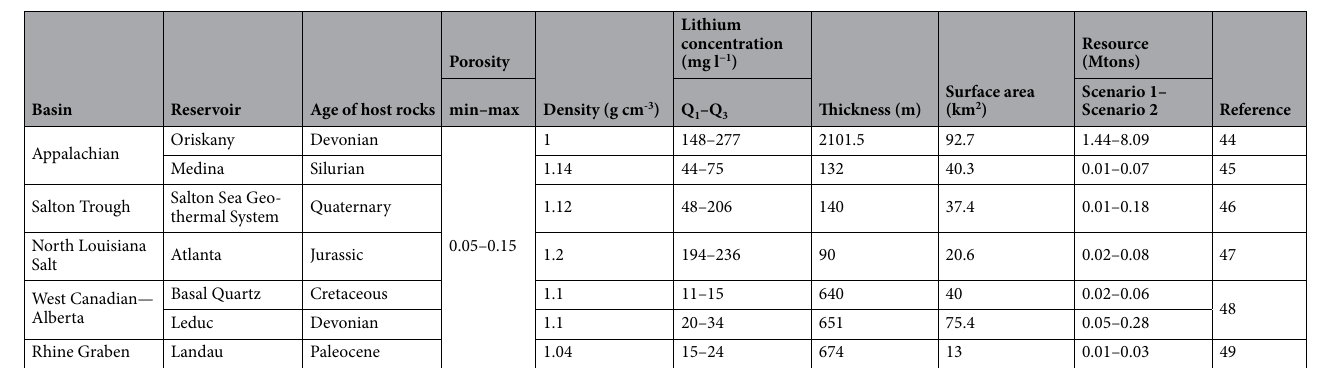
Lithium geochemistry in sedimentary formation waters